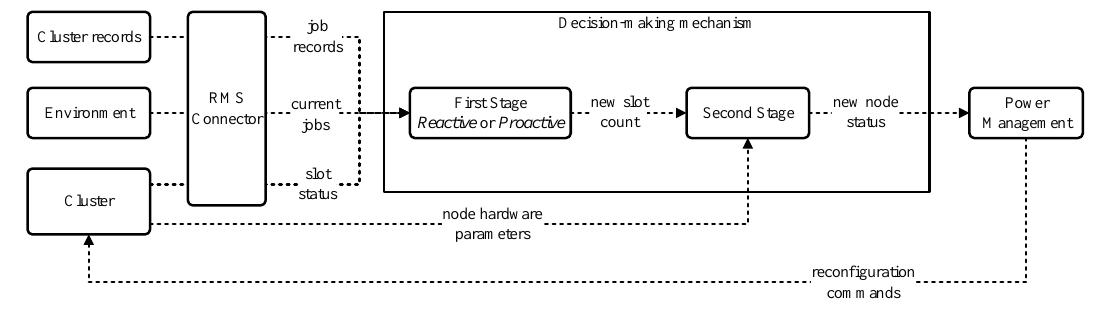
Figure 3. EECluster control